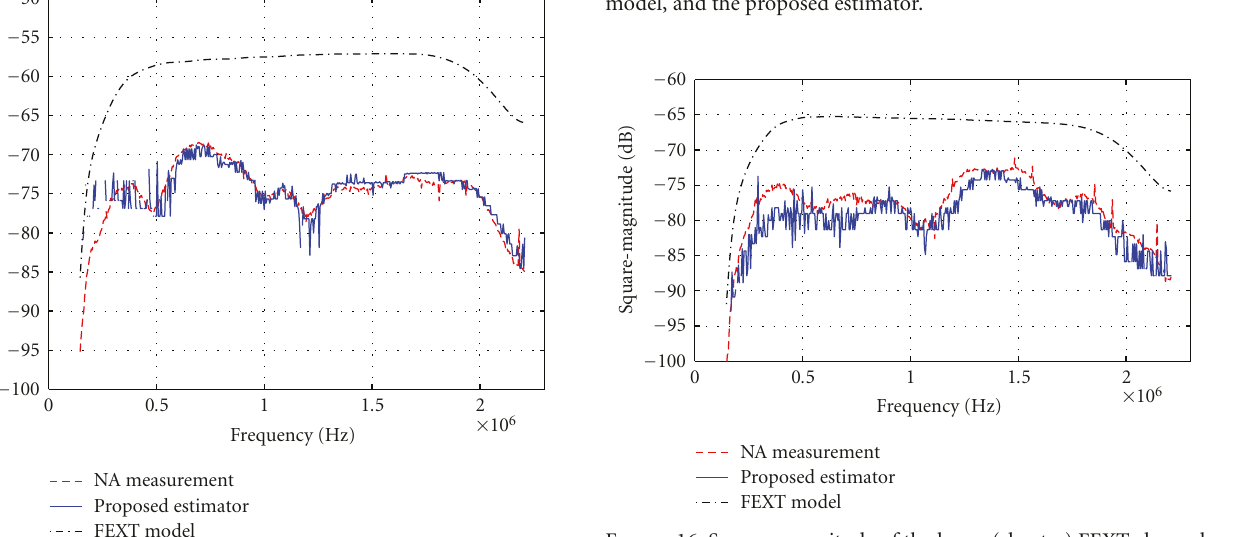
Figure 16: Square-magnitude of the lower (shorter) FEXT channel for access network scenario III obtained with the NA, the FEXT model and the proposed